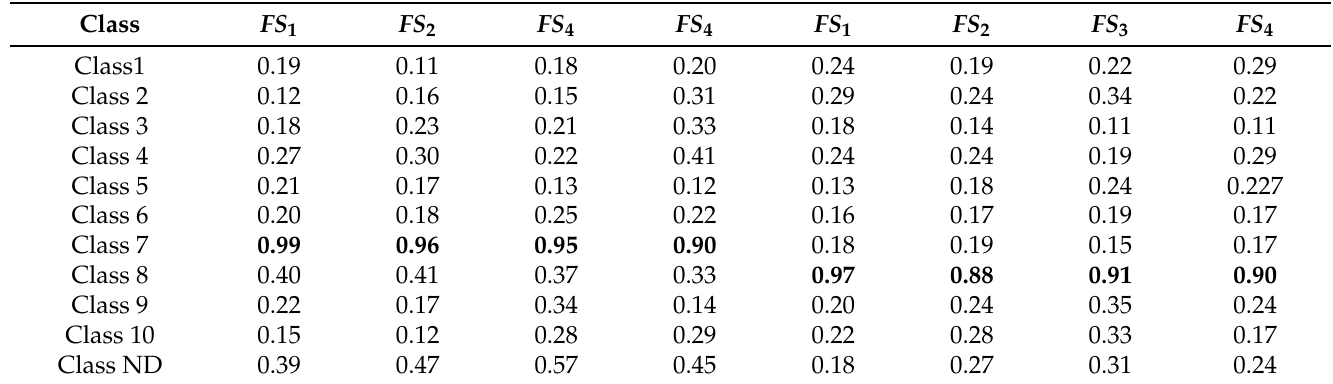
Table 8. FS 1 , FS 2 , FS 3 and FS 4 values obtained by comparing the EC maps of classes 7 and 8 with the remaining classes (the values highlighted in bold refer to the best performances).